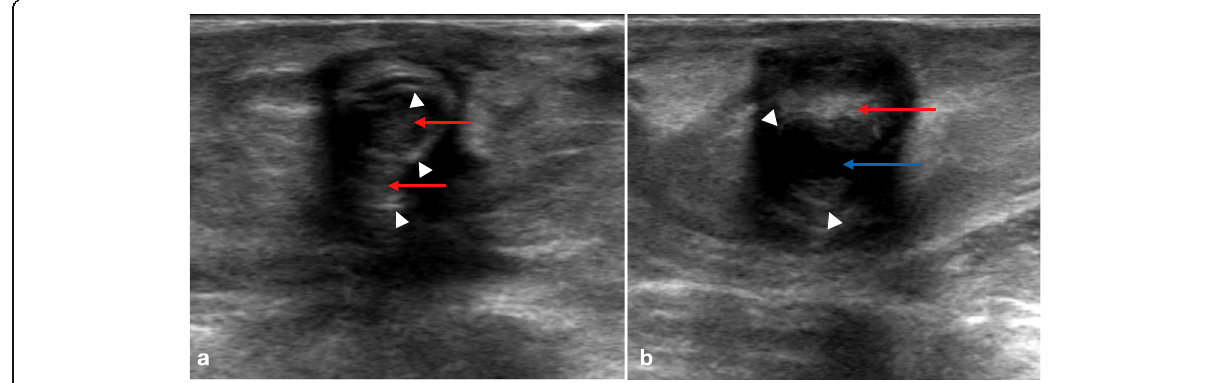
Fig. 1 a, b Doppler ultrasonography of left brachio-axillary arteriovenous graft showing echogenic linear material floating distinctly within the graft lumen (blue arrow), suggestive of delaminated graft fabric layers (arrowheads). It also shows thrombus in the false lumen created by graft delamination and an intraluminal thrombus (red arrows) ( a